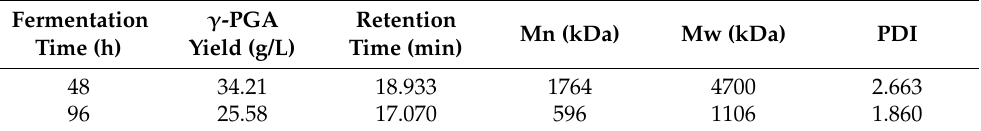
Table 1. Characteristics of γ -PGA fermented by B. subtilis